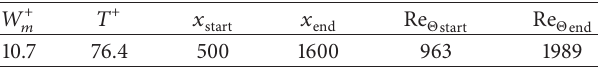
Table 2: Parameters regarding the wall oscillations for the simula- tion